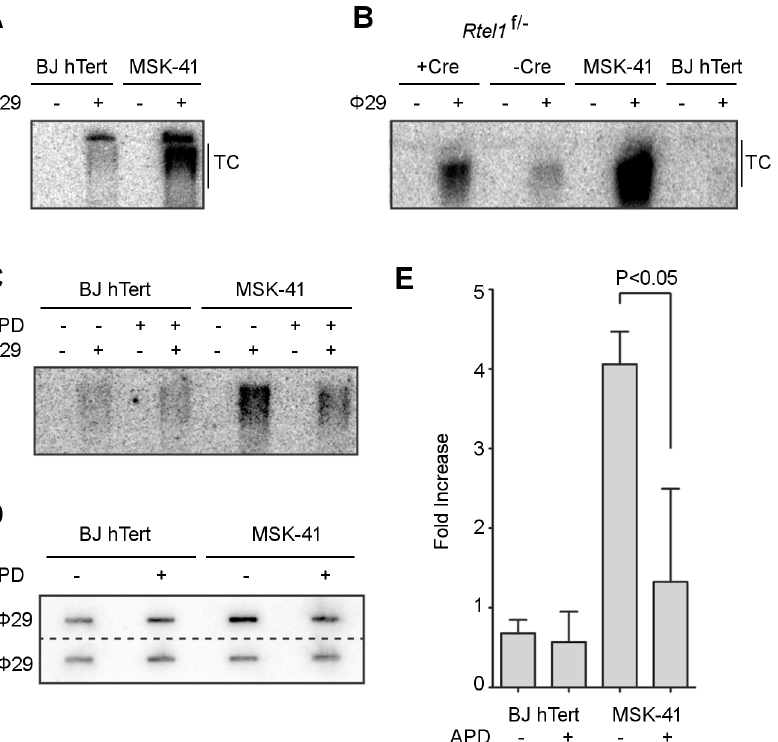
Figure 4. Inhibiting DNA replication blocks T-circle formation in MSK-41 RTEL1 R1264H cells. (A) Phi29-dependent T-circles in BJ hTERT and MSK-41. (B) Phi29-dependent T-circles in RTEL1 floxed/- MEFs 6 Cre, BJ hTERT and MSK-41. (C) Phi29-dependent T-circles in BJ hTERT and MSK-41 6 aphidicolin (APD; 5 m M). (D) Dot blot of the Phi29-dependent T-circles in BJ hTERT and MSK-41 6 aphidicolin (APD; 5 m M). (E) Quantification of the fold increase in intensity of Phi29-dependent T-circles in the different cell lines subjected to the indicated treatments. Intensity mean and standard deviation were calculated over two independent experiments; statistical analysis (one-way ANOVA) was calculated with Prism (GraphPad).